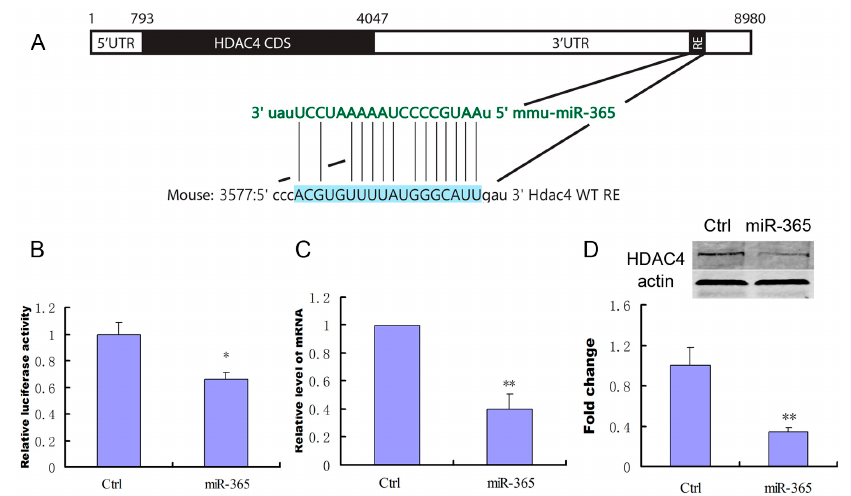
Figure 5. Histone deacetylase 4 (HDAC4) is a direct target of miR-365 in MC3T3-E1 cells. ( A ) Schematic diagram of putative miR-365 seeding-site (Response Element, RE) in 3 ′ -UTR of HDAC4 mRNA; ( B ) pmirGLO-HDAC4 3 ′ -UTR wild-type gene was co-transfected with the negative control or miR-365 mimic into MC3T3-E1 cells respectively. Cells were harvested for quantification of dual luciferase activities at 24 h post transfection ( n = 3); ( C ) qPCR analysis of the changes of the mRNA expression of HDAC4 in MC3T3-E1 cells after treatment with miR-365 mimic or negative control ( n = 3); ( D ) Western blot analysis of the changes in HDAC4 protein in MC3T3-E1 cells after treatment with miR-365 mimic or negative control for 72 h ( n = 3). * p < 0.05, ** p < 0.01 compared to control. 2.6. MiR-365 Increased Runx2 Expression and HDAC4 Over-Expression Inhibited this Effect Runx2 plays an important role in osteoblast differentiation [12]. To determine whether miR-365 regulates Runx2 in MC3T3-E1 cells, we quantified the Runx2 mRNA level. MiR-365 transfection significantly increased the expression of Runx2 mRNA. Co-transfection of HDAC4 cDNA significantly inhibited the increase of Runx2 promoted by miR-365 (Figure 6). These data suggest that miR-365 can regulate the expression of Runx2 via inhibition of the HDAC4 pathway.